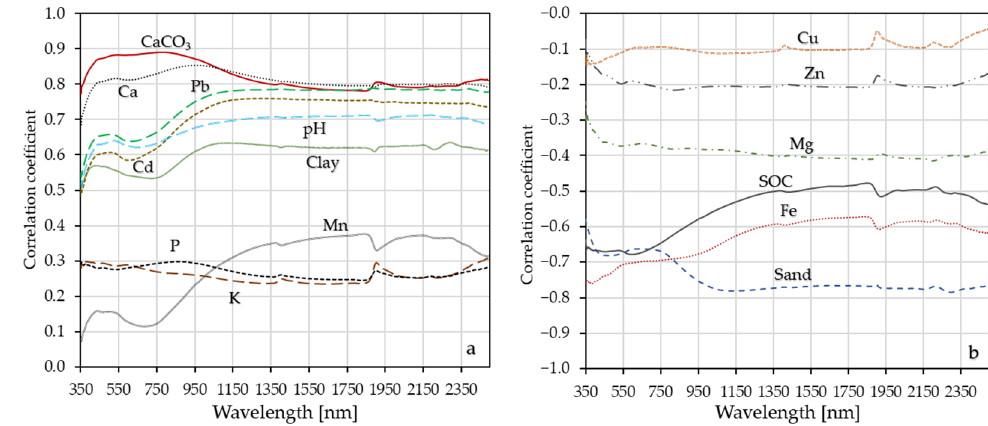
Figure 3. Correlations between soil properties and spectral reflectance across the 350–2500 nm wavelength region (( a )—positively and ( b )—negatively correlated soil properties).